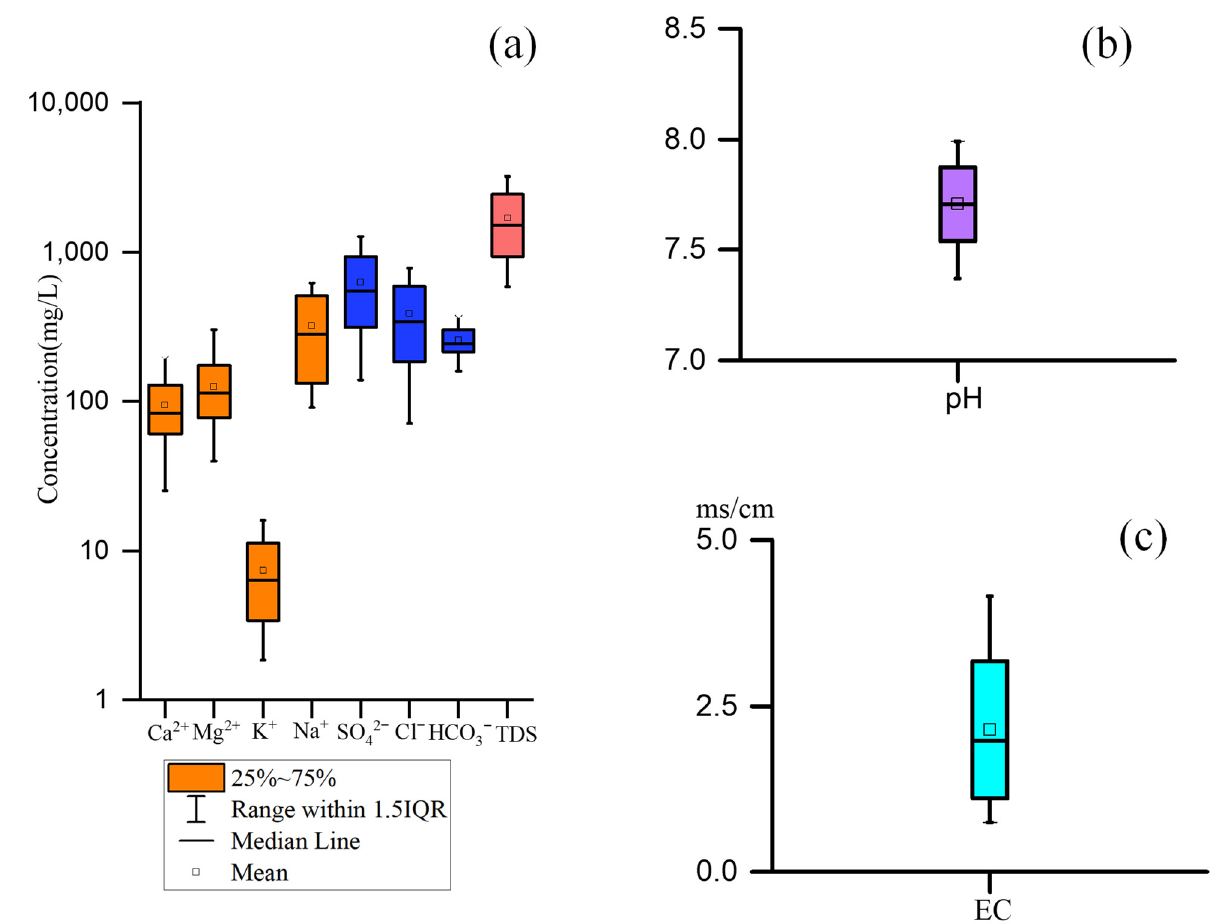
Figure 3. Boxplots of hydrochemical parameters in groundwater of the Yaoba Oasis. ( a ) major ions and TDS; ( b ) pH; ( c ) EC.